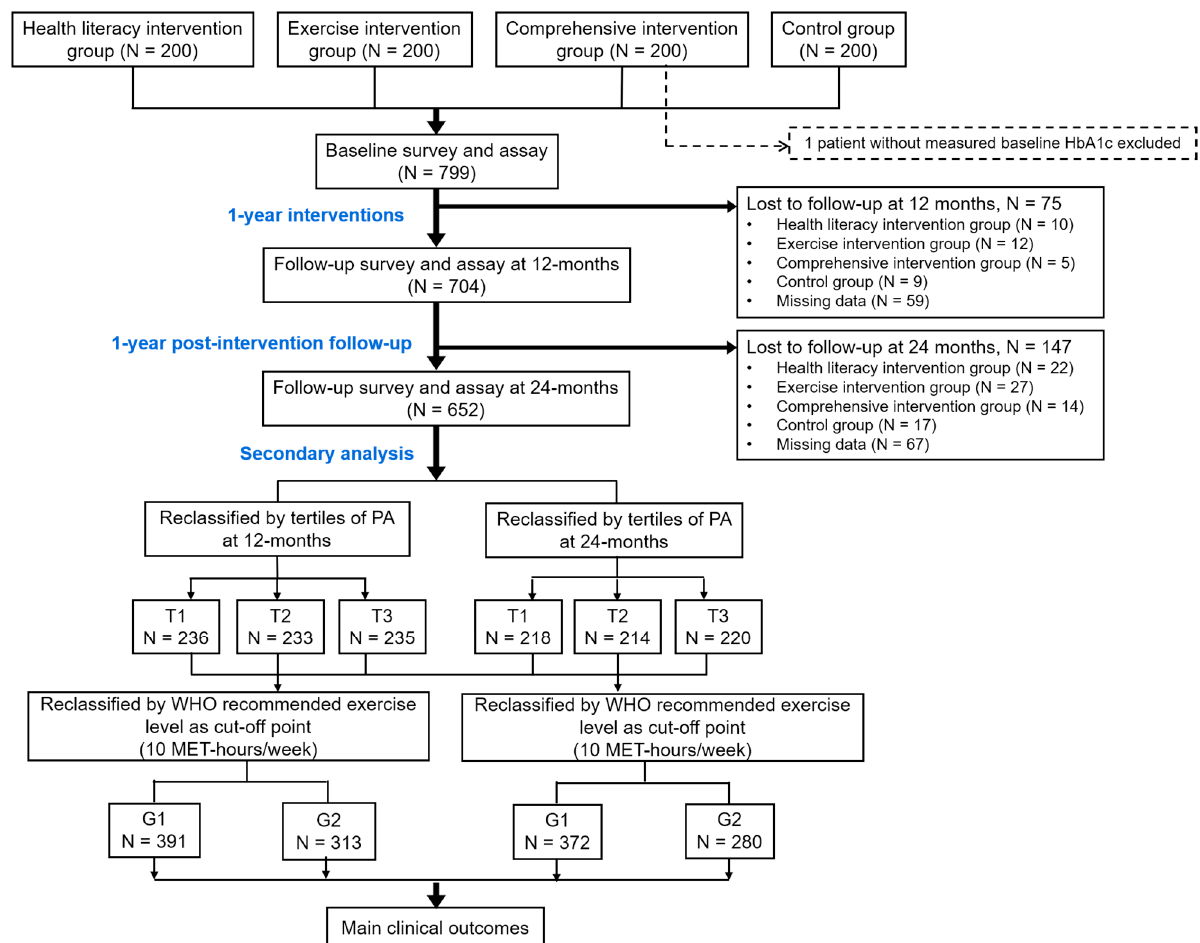
Figure 1. Flow diagram of the study. PA: Physical Activity; T1-T3: Group 1–3 by tertiles of PA; G1-G2: Group 1-2 by WHO (World Health Organization) recommended exercise level.